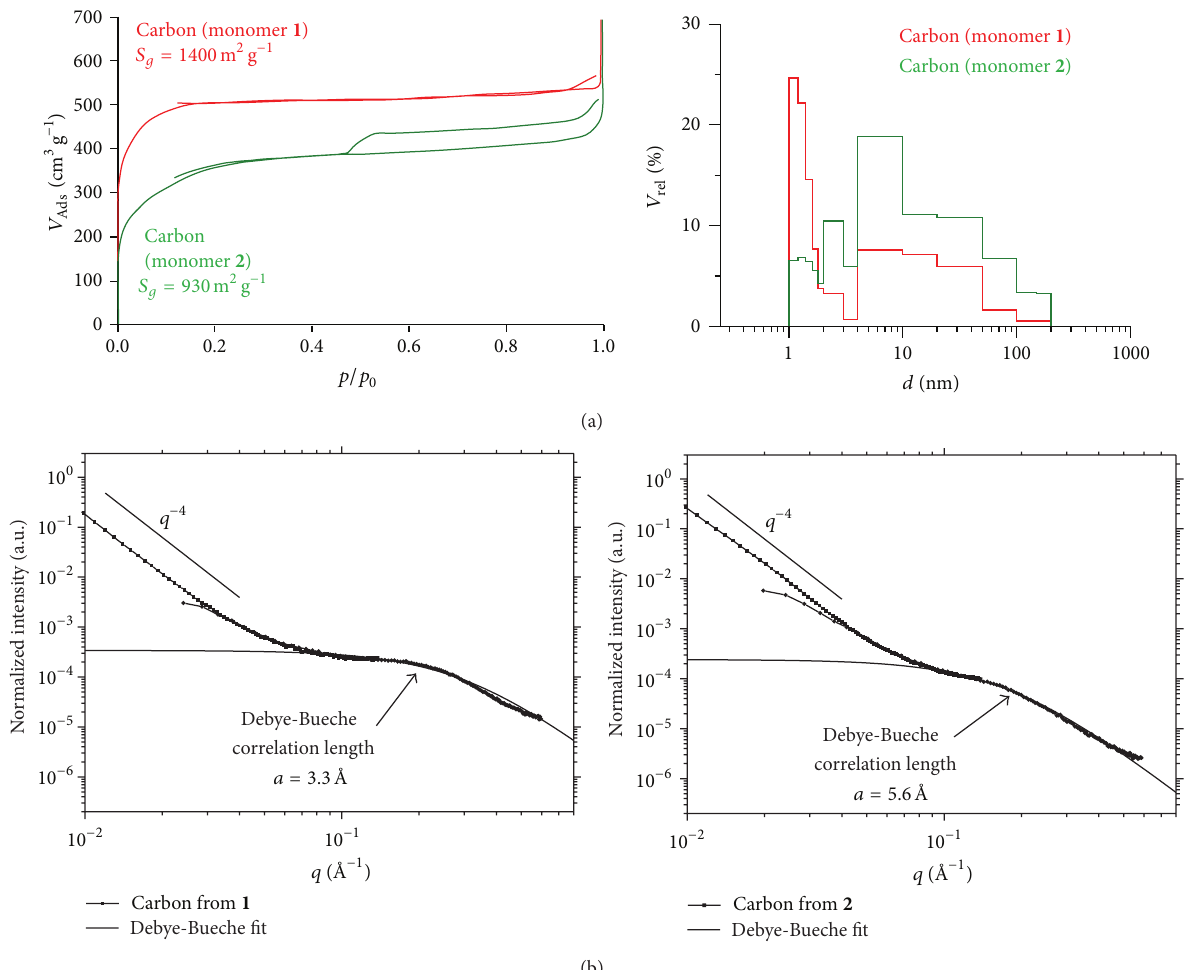
Figure 2: (a) Nitrogen-sorption-isotherms and pore-size distribution plots of carbon from template-free TP by acidic induction; (b) SAXS measurements of those carbon